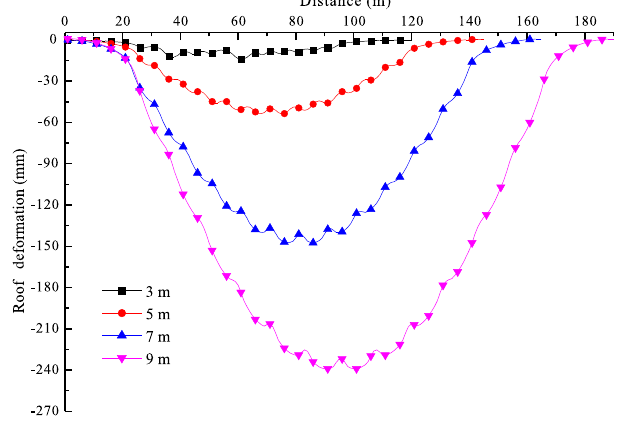
Figure 13. Roof subsidence after quadratic stabilization.